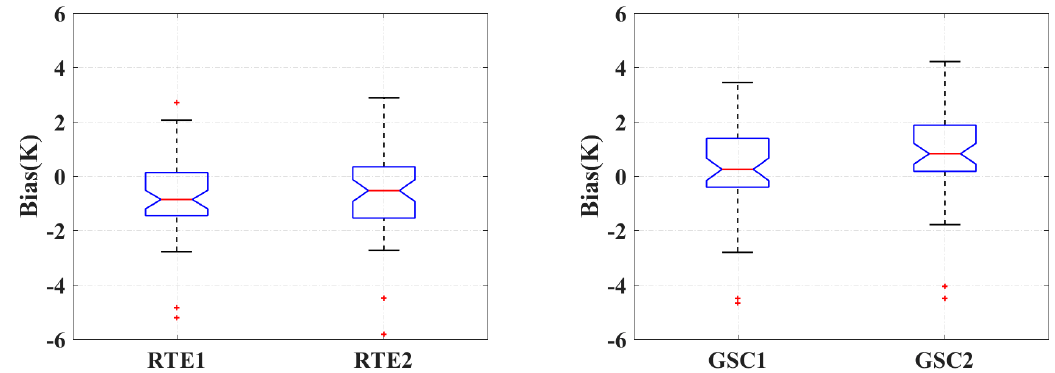
Figure 9. Boxplots between estimated LSTs from RTE algorithm ( left ) or GSC algorithm ( right ) at 250 m resolution and in situ LSTs.